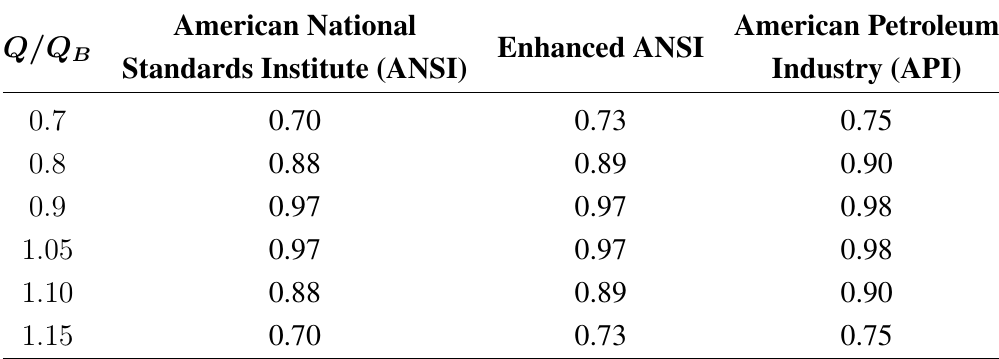
Table 1. µ values for different manufacturing standards at different flow